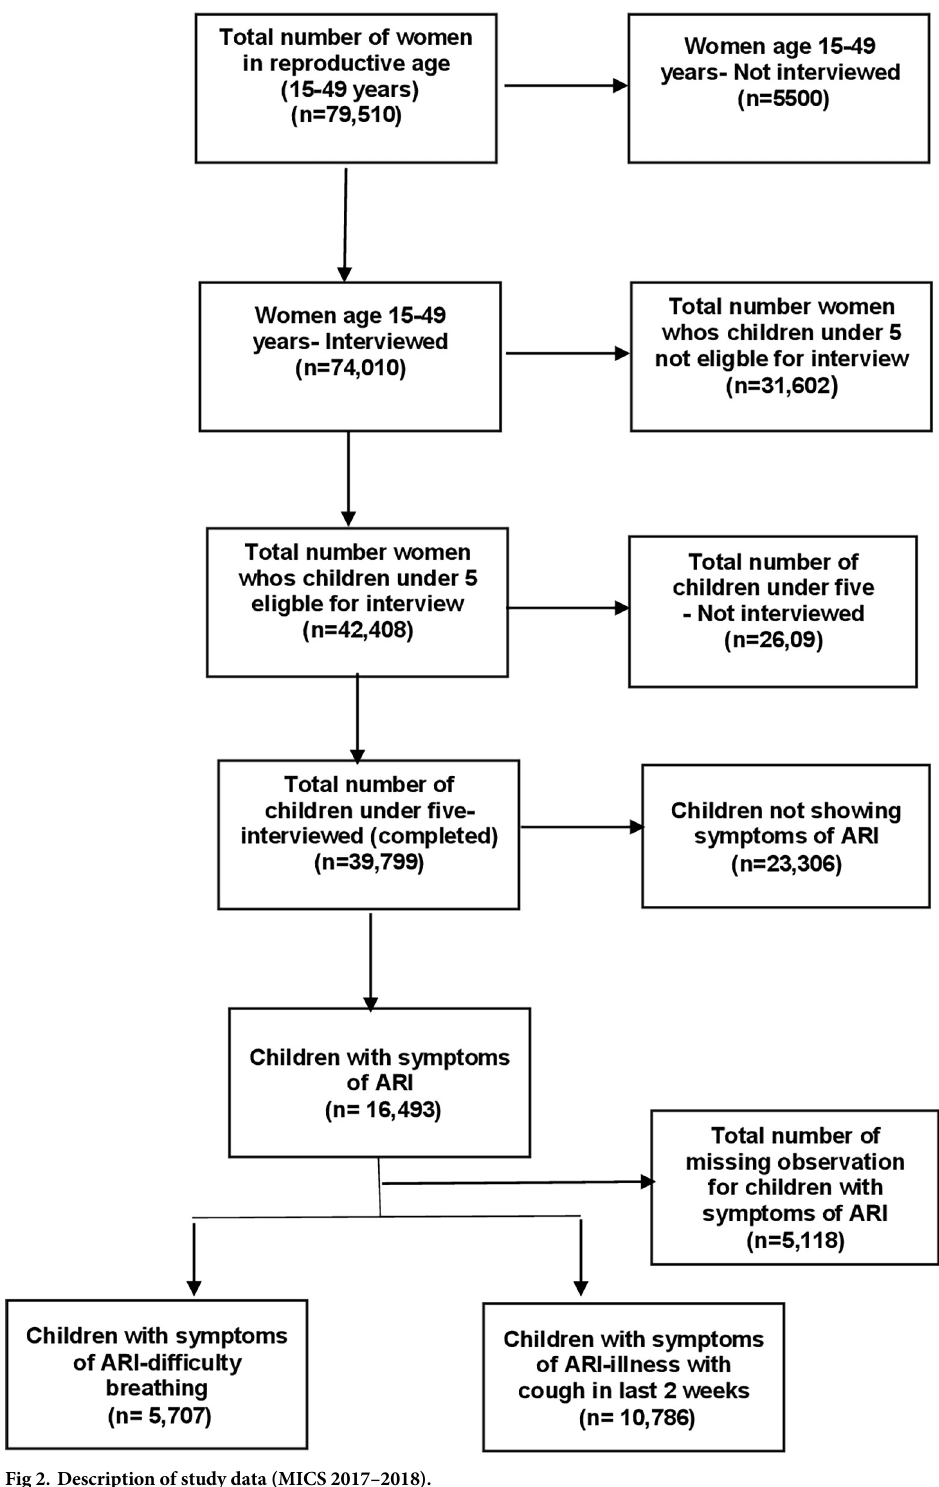
Fig 2. Description of study data (MICS